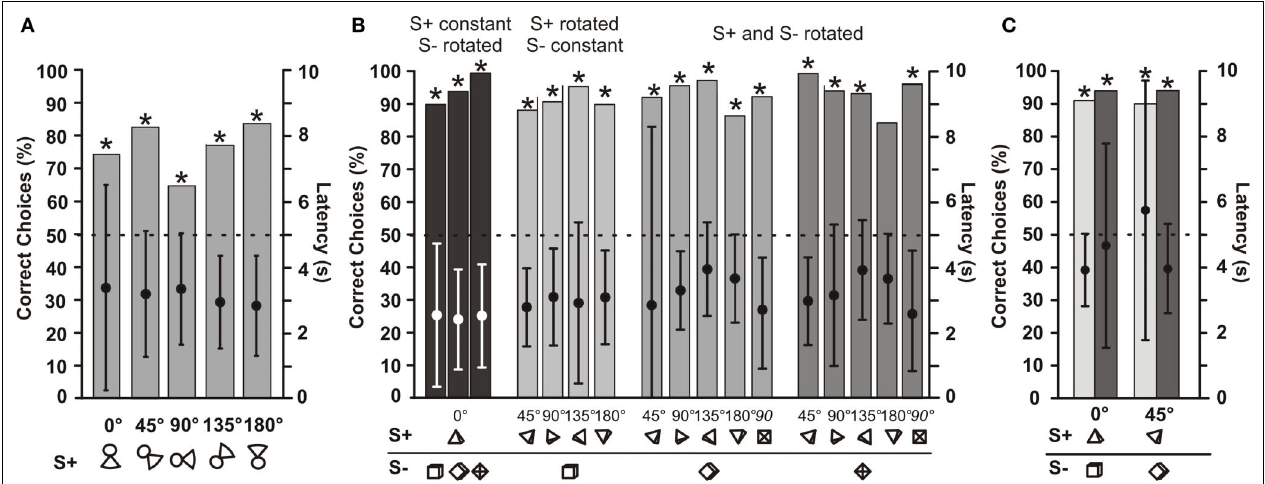
FIGURE 5 | Tests for rotational invariance. (A) Mean choice frequencies for S + by fi sh 1, which was trained and tested to discriminate between a S + (‘little man’) and one of six different S − . Each column shows the mean results with the S + rotated in the vertical plane parallel to the dividing wall by a certain angle (numbers give the rotation angles). N > 195 (B) Mean choice frequencies of fi sh 3, which was trained to discriminate between a non-rotated (0 ° ) pyramid (S + ) and a non-rotated (0 ° ) cube, symbols of which showing the rotation angle are given below each bar along the abscissa. The symbols show